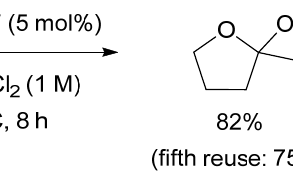
Figure 5. Cyclisation of 4 ‐ pentyn ‐ 1 ‐ ol catalysed by recovered gold, Reproduced with permission from [68].